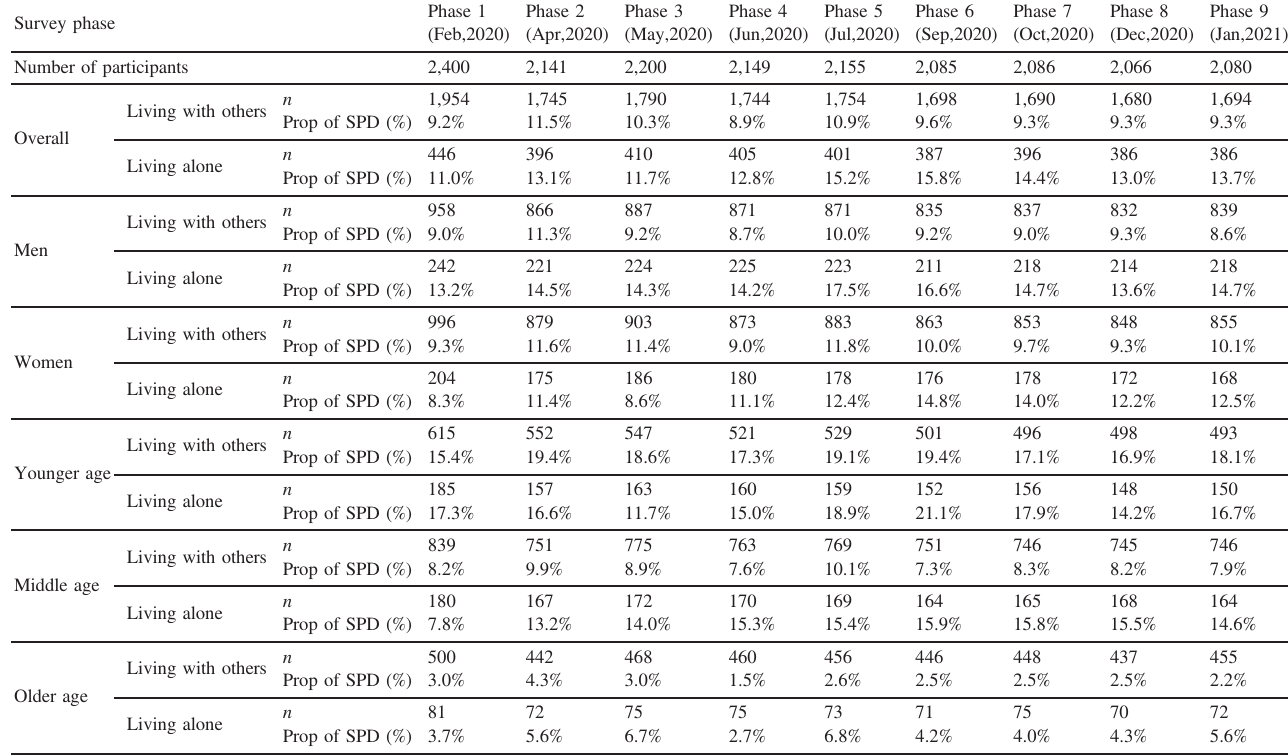
Table 2. The number of participants and proportions of SPD by survey phases Survey